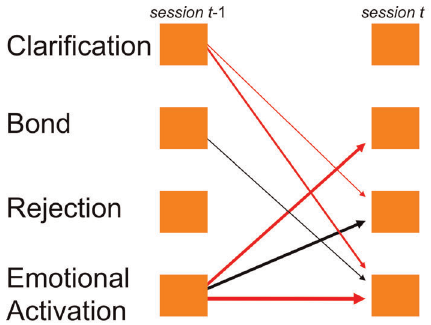
Figure 5. Time-lagged associations with significant links to outcome. Time-lagged associations with significant links to outcome (SET patients). Black (red) arrows indicate those associations that predicted positive (negative) outcome. Thickness of arrows indicates the number of ‘hits’ (cf. Table 3). patients from different PD categories. TSPA also indicated which specific process components were linked with therapy outcome.